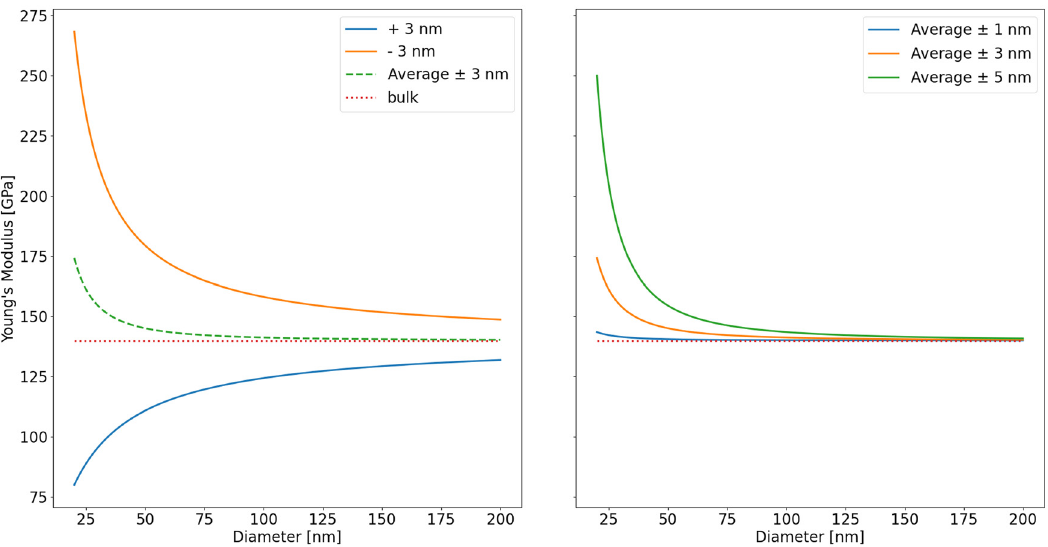
Figure 9: Apparent dependence of Young ’ s modulus on NW diameter arti fi cially caused purely by uncertainties in diameter